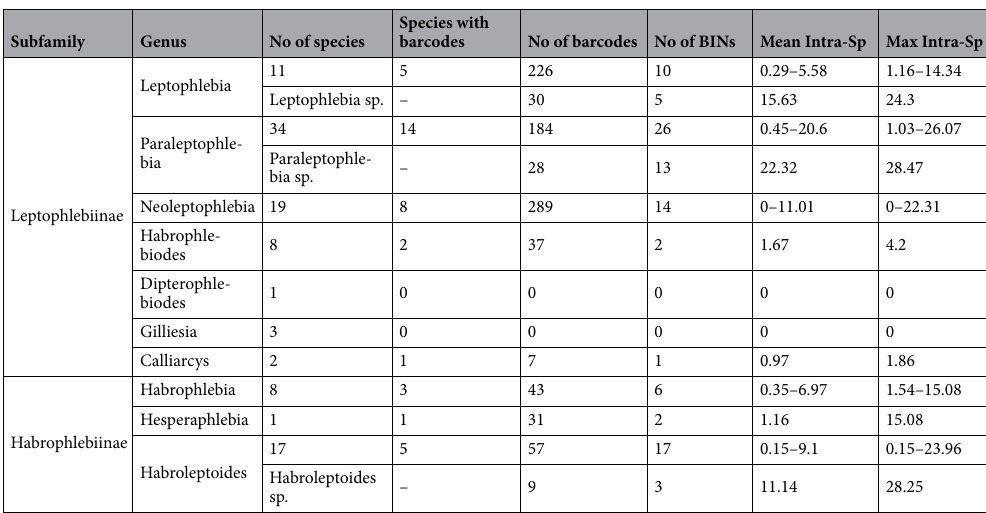
Table 3. Overview of barcoding statistics and molecular distances based on the Kimura 2-parameter model of the analysed specimens of the analysed Leptophlebiinae and Habrophlebiinae. BINs are based on the barcode analysis from